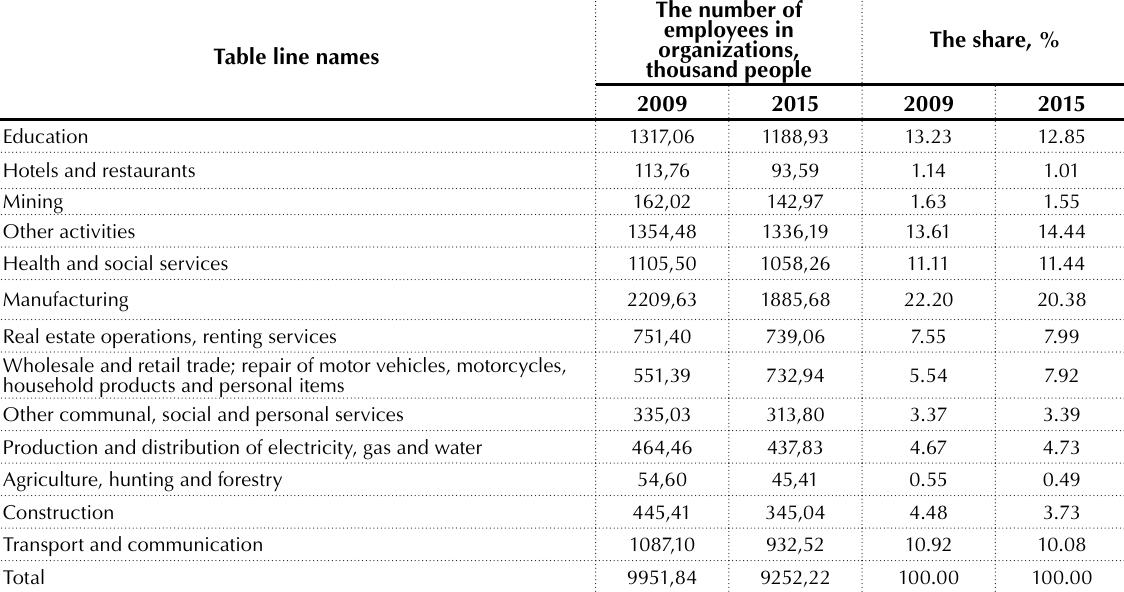
Table 2. Dynamics of the number of employees in organizations in all cities studied in 2009–2015